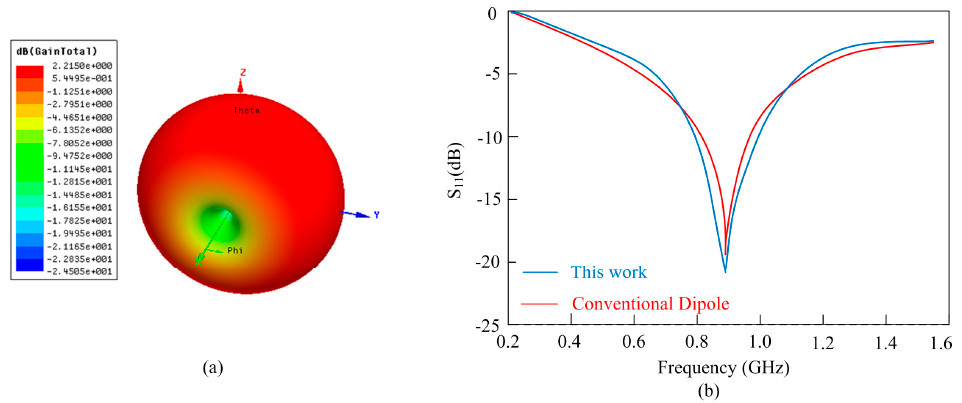
Figure 10. Antenna performances: ( a ) radiation pattern; ( b ) S 11 performance.